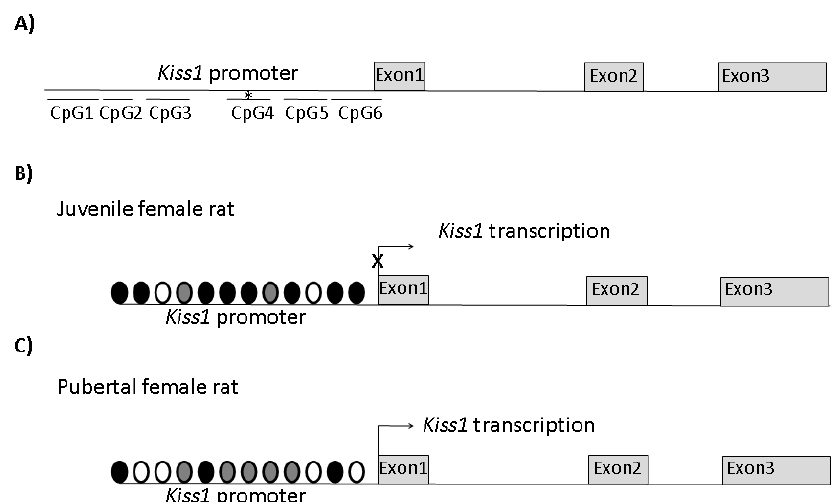
Figure 1. Schematic representation of the main epigenetic changes in the Kiss1 promoter occurring at puberty in female rats. Six CpG rich regions (CpG1-6) were predicted within the first 2kb 5 (cid:48) upstream at the transcription start site of Kiss1 ; the methylation status (*) of CpG4 changes at puberty ( A ). The main histone modifications of the Kiss1 promoter in juvenile ( B ) and pubertal ( C ) rats. Undernutrition and overnutrition mimic conditions in (B) and (C), leading to delayed puberty or precocious puberty, respectively. Black circles, H3K27 trimethylation; white circles, H3K9 / 14 acethylation; gray circles, H3K4 trimethylation. The length of the Kiss1 promoter, CpG-rich regions, exons, and introns are not represented in scale. Modified from [41] and